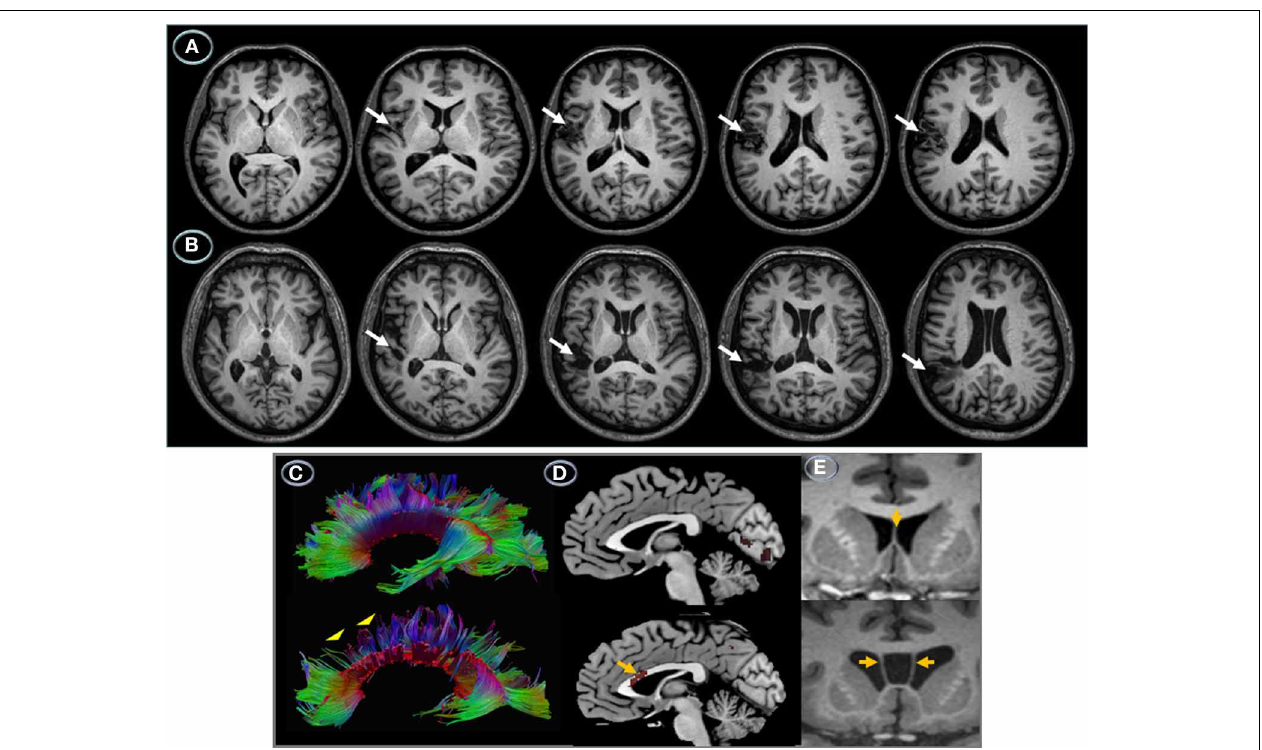
the left sensorimotor cortex, this did not result in noticeable changes in the anterior segments of the corpus callosum. The rostral body of corpus callosum in JGG shows diminished streamlines (C) , bottom panel (yellow arrowheads) and decrement of metabolic activity (D) , bottom panel (yellow arrow). The fact that structural and functional involvement of the anterior corpus callosum in JGG does not interrupt fibers interconnecting the damaged left temporoparietal cortex with its homologous in the right hemisphere suggests that corpus callosum involvement was unrelated to the stroke lesion. Anatomical MRIs show normal septum pellucidum (grade 0, normal) (yellow arrow) in RTP (E) , top panel and an enlarged cavum septum pellucidum (grade 4, severe) (Degreef et al., 1992; DeLisi et al., 1993; Kim and Peterson, 2003) in JGG (yellow arrows) (E , bottom panel )